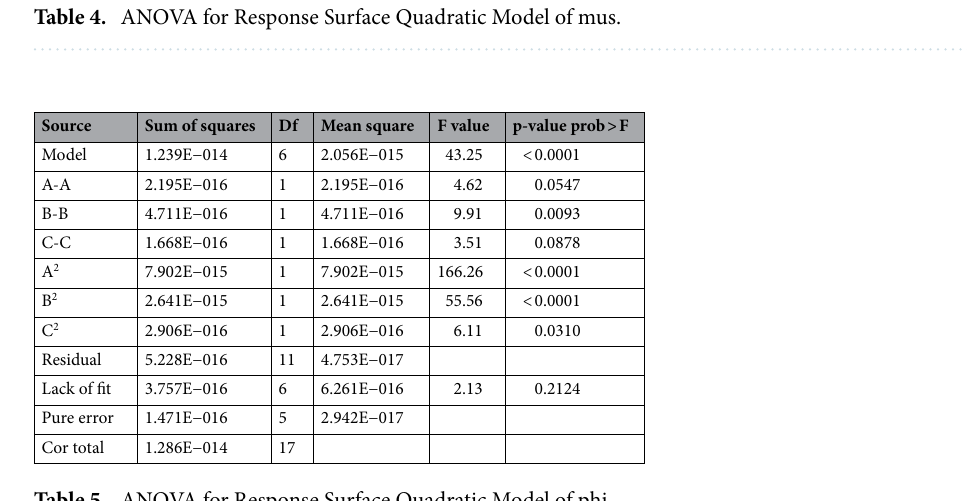
Table 5. ANOVA for Response Surface Quadratic Model of